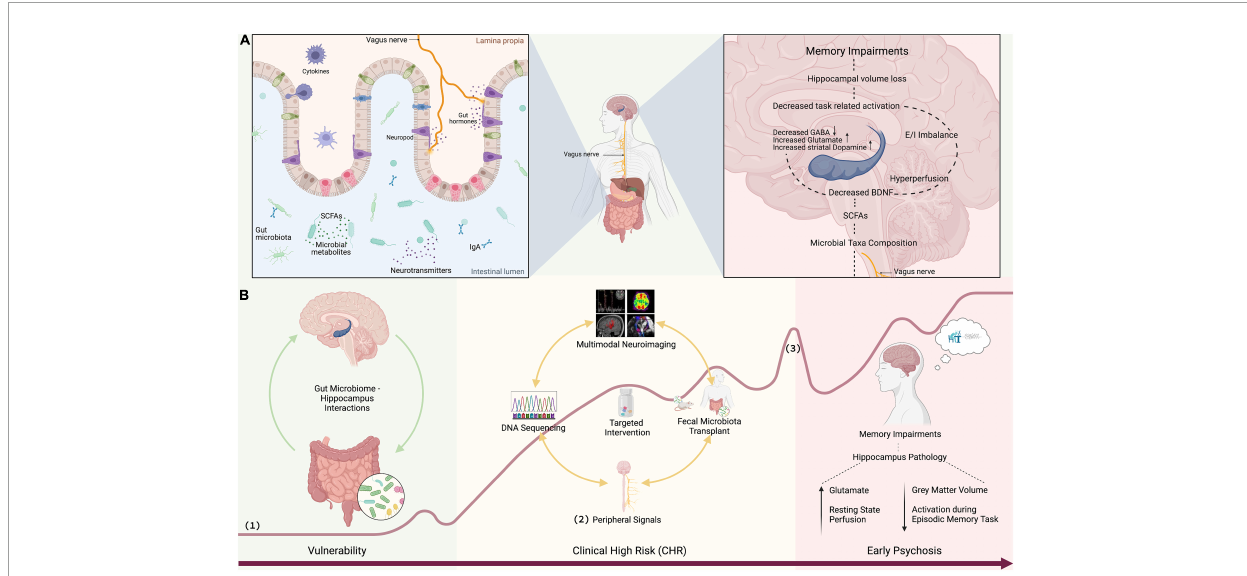
FIGURE1 (A) SCFAs produced by bacterial commensals in the gut signal the brain via vagus nerve or neurotransmission influencing glutamate and GABA synthesis (54). Vagal sensory signaling enhances memory (49), facilitates neurogenesis, and increases the expression of BDNF (50, 51). A decrease in the BDNF, which regulates hippocampal neuroplasticity (46), decreases learning and memory functioning (47). GABAergic and glutamatergic neurotransmission drives elevated striatal dopamine (20–22). Hippocampal hyperperfusion predicts hippocampal volume loss (26). Hippocampal hyperactivity results in excitation/inhibition (glutamate/GABA) imbalance which contributes to hippocampal volume loss (39, 40) leading to memory impairment. (B) Discovery of gut microbiome markers: (1) curve of psychosis progression adapted from Fusar-Poli et al. (118) and Schultze-Lutter et al. (119), (2) peripheral signals such as stress (e.g., cortisol, sirtuins), inflammation (e.g., CRP, IL, TNF- α ), plasticity (BDNF), and vagal signaling (e.g., ghrelin), and (3) first psychotic episode. Figure 1 was created with